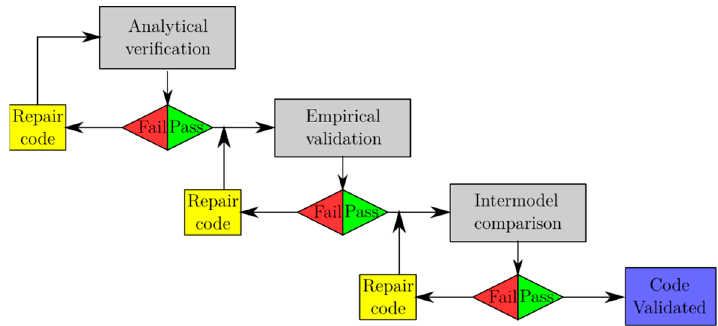
Figure 3. BESTEST validation scheme.